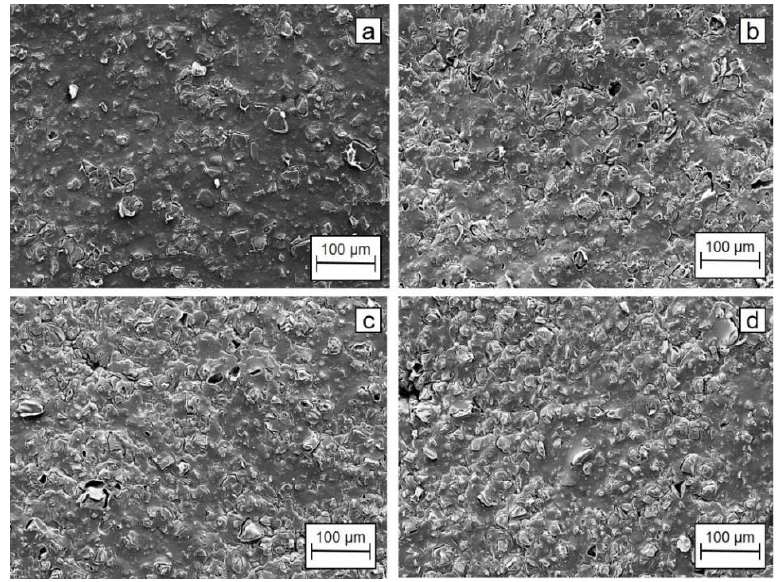
Figure 7. SEM images of ( a ) unused membrane, and after tests in ( b ) acidic anolyte, ( c ) neutral anolyte, and ( d ) alkaline anolyte. and ( d ) alkaline